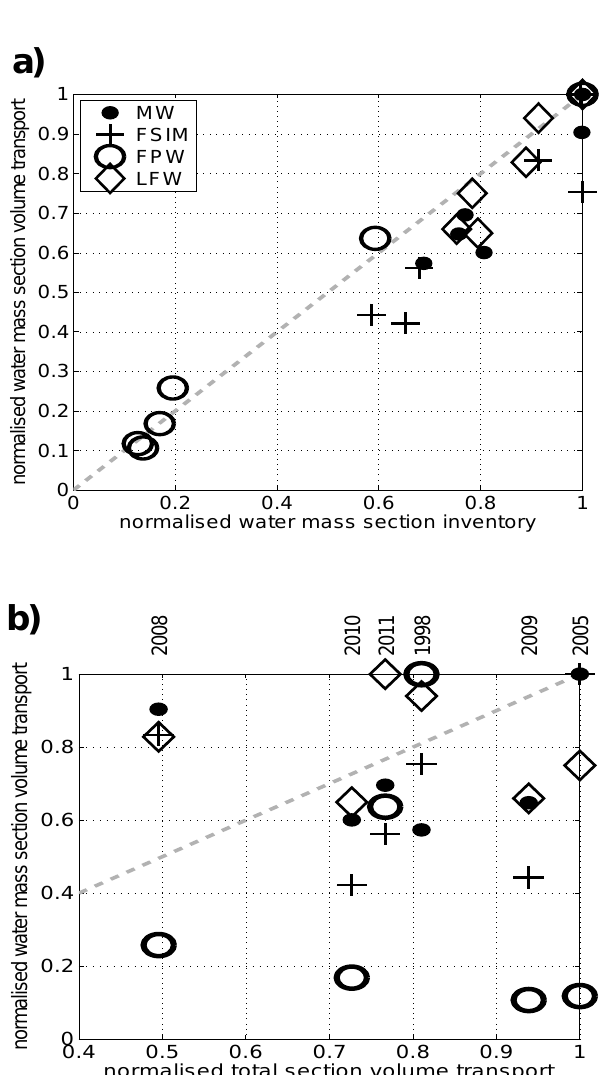
Fig. 6. Meridional section transports of LFW components vs. sec- tion inventories of LFW components (a) . LFW component trans- ports vs. volume transports in the upper 300m (b) . Here, section inventories and section transports were calculated between 10.6 ◦ W and 4 ◦ E; the section inventories are based on the fractions of LFW components in Dodd et al. (2012). All values are normalised by the respective maximum of all six campaigns, so that the maximum section transport/inventory of each quantity is at unity. Inventories and transports of FSIM were multiplied by − 1 (FIFB section in- ventories and transports). Symbols denote different transport com- ponents: MW (dots), FIFB (plus), FPW (circles) and LFW (dia- monds). The thick grey line depicts an exact linear relationship be- tween each